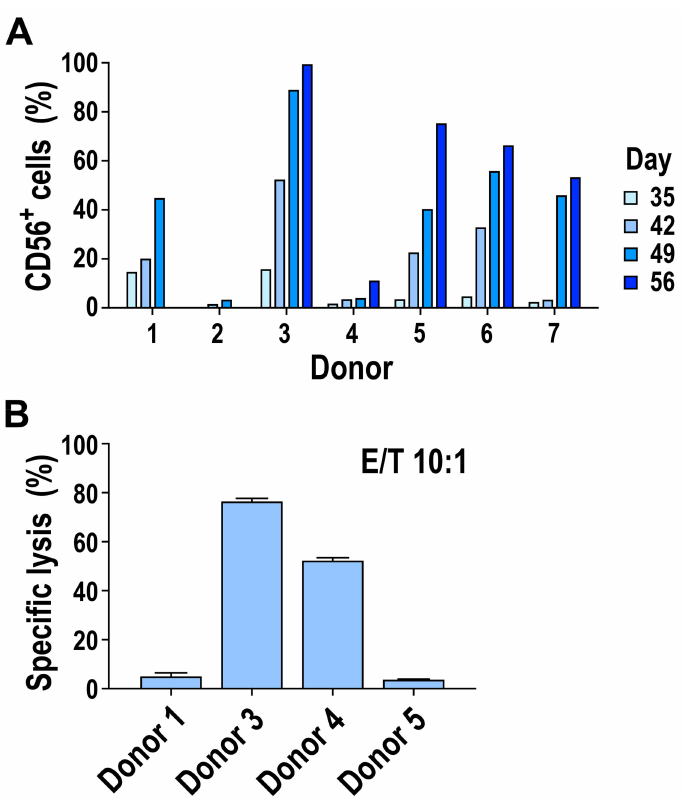
Figure 3. Donor-to-donor variation in the generation of CD56 + NK cells from mobilized PB-CD34 + cells. Mobilized HSCs from seven healthy donors were cultured ex vivo following the scheme depicted in Figure 1A. ( A ) Development of CD56 + NK cells was analyzed at the indicated time points of the culture period by flow cytometry. For donors 1 and 2, no data were available for day 56, or for days 35 and 56, respectively. ( B ) Cytotoxicity of CD56 + NK cells generated from PB-CD34 + cells was determined in flow-cytometry-based cell killing assays at an e ff ector to target (E / T) ratio of 10:1. Mean values ± SEM of three technical replicates for each donor are shown. Identical donor numbers in (A) and (B) indicate the same